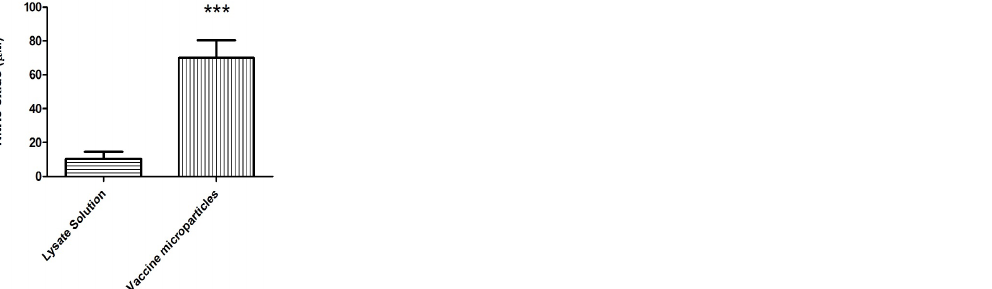
uptake. In this study, antigens were presented as complexes with both MHC II and I mol- ecules.